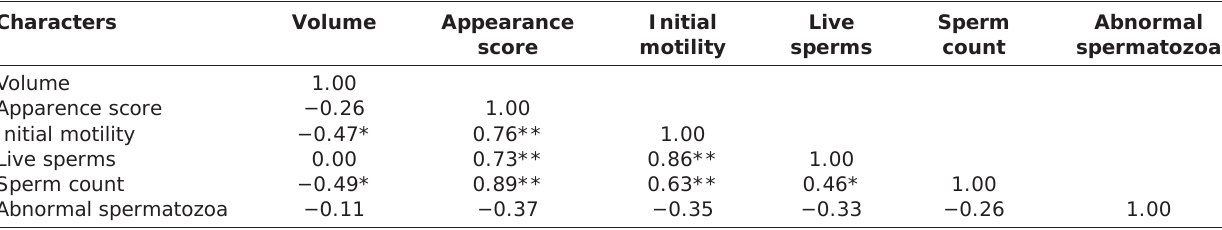
Table-2: Correlation matrix of different semen quality characters of RIR roosters. Characters